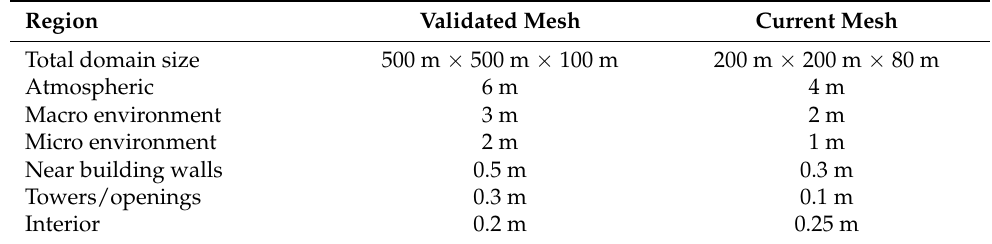
Table 1. Representative cell sizes of the generated